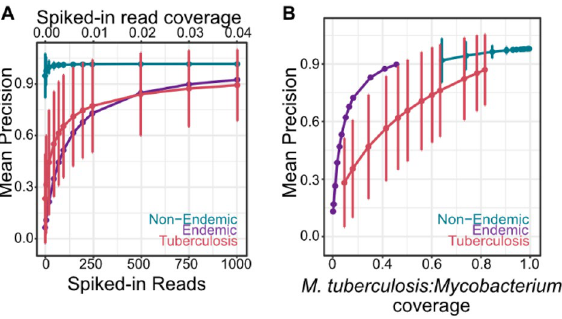
Figure 4. ( A ) Classification precision of synthetic M. tuberculosis reads spiked into non-endemic urine samples (n = 29, 5 replicates per sample), endemic urine samples (n = 23, 5 replicates per sample), and tuberculosis urine samples (n = 66, 5 replicates per sample). ( B ) The classification precision is correlated with the relative coverage of M. tuberculosis to total Mycobacterium in the